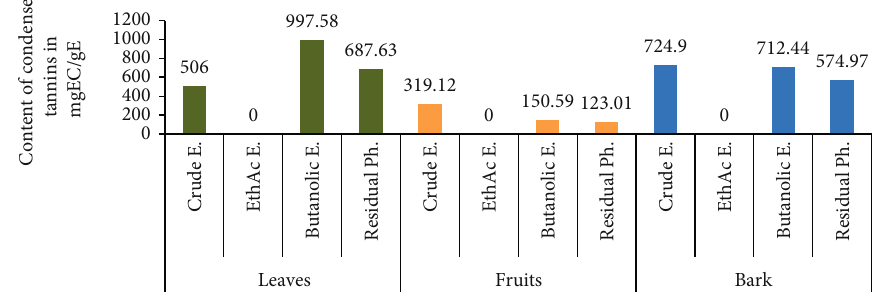
Figure 4: Content of condensed tannins in mgEC/gE.